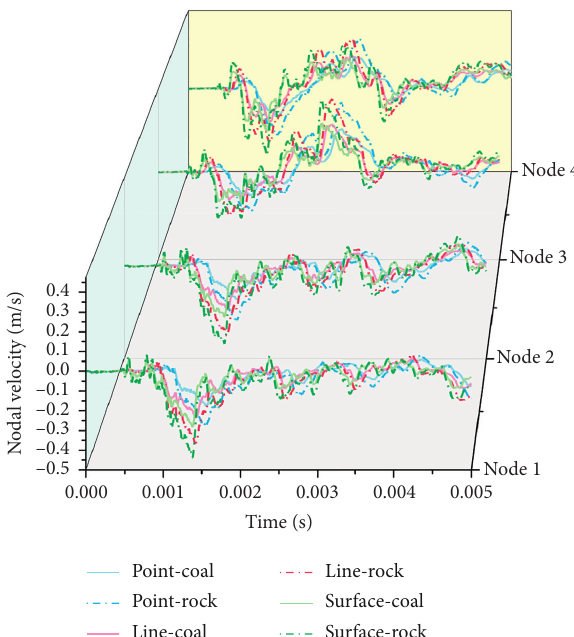
Figure 20: Nodal velocity in the tail beam noncollision contact zone under different contact